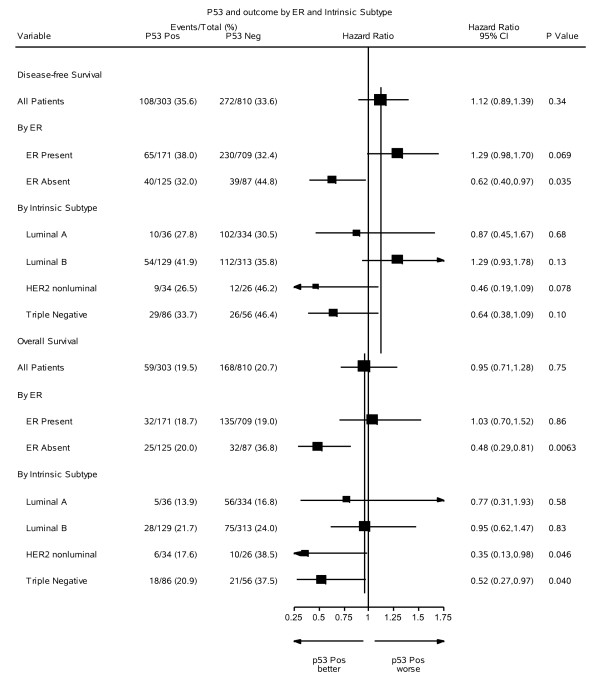
Forest plots of hazard ratios for disease-free and overall survival by p53, estrogen receptor (ER) expression and intrinsic subtype.